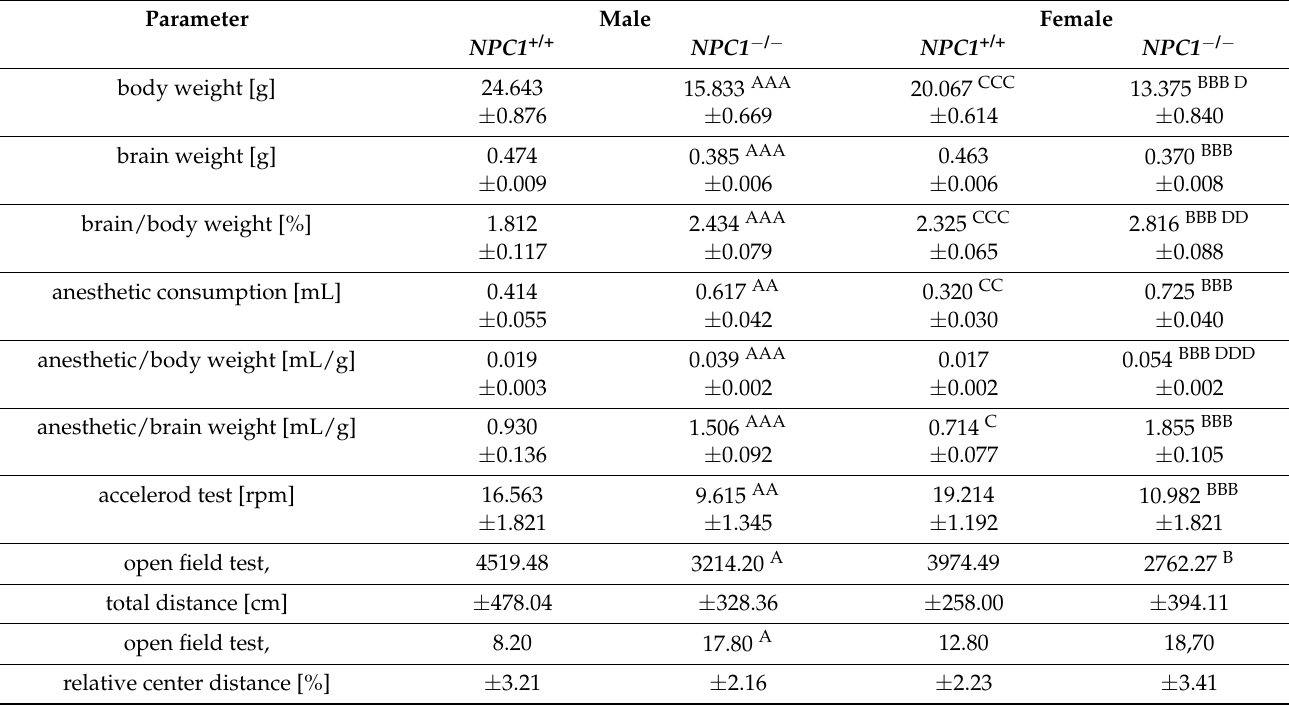
Table 1. Mean values ± SEM of the evaluated parameters of untreated (None groups) male and female NPC1 +/+ and NPC1 − / −